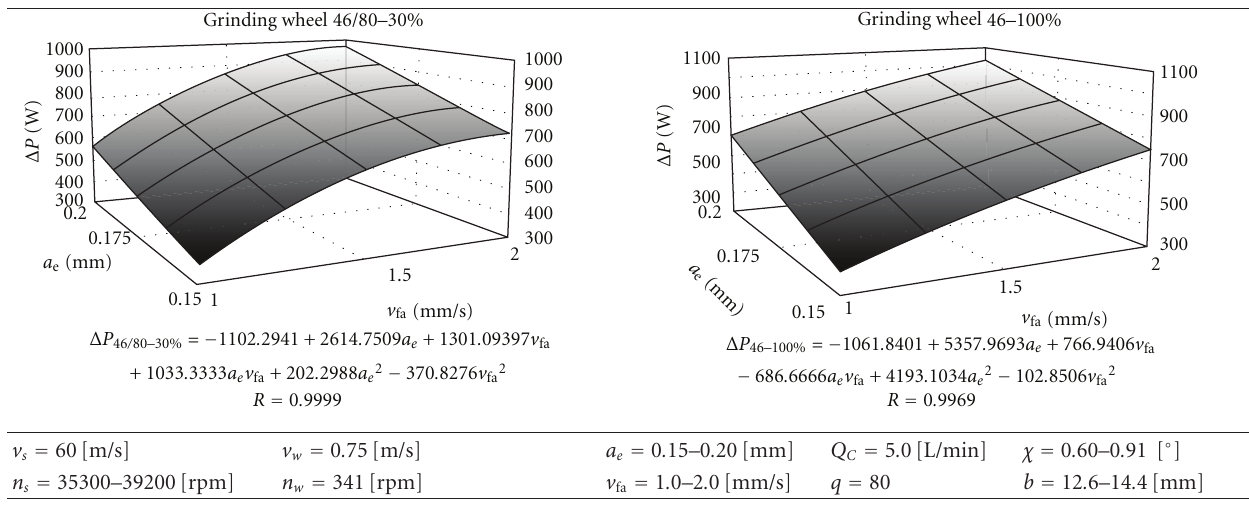
Table 2: Breakdown of mathematical models describing the grinding power gain Δ P as a function of the working engagement a e and axial table feed speed v fa